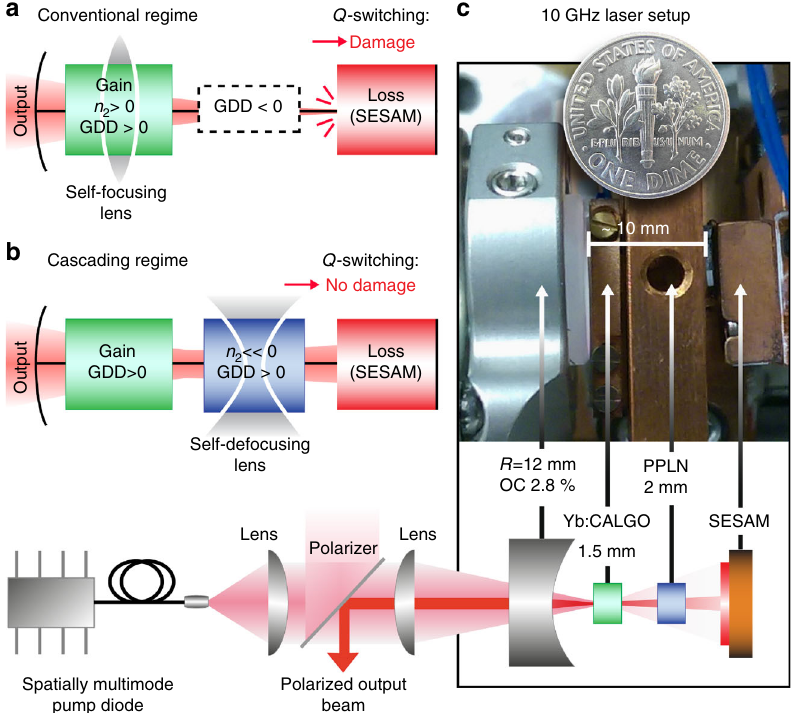
Fig. 1 Modelocking regime and laser setup. a Conventional soliton modelocking, where positive self-phase modulation (SPM) with n 2 > 0 is balanced by negative group-delay dispersion (GDD). In a straight-cavity con fi guration with a fl at SESAM as an end-mirror, high peak powers during Q -switching instabilities cause self-focusing of the laser on the cavity elements, inducing damage and thereby preventing continuous wave modelocking. b Soliton modelocking using a self-defocusing nonlinearity to provide negative SPM that is balanced by positive GDD. In addition the strong negative effective Kerr nonlinearity creates a dynamic defocusing lens that leads to an increase of the mode size in the event of Q -switching instabilities, hence protecting the elements from damage. c Schematic and photo of the 10 GHz Yb:CALGO laser cavity, which is pumped by a spatially multimode pump diode